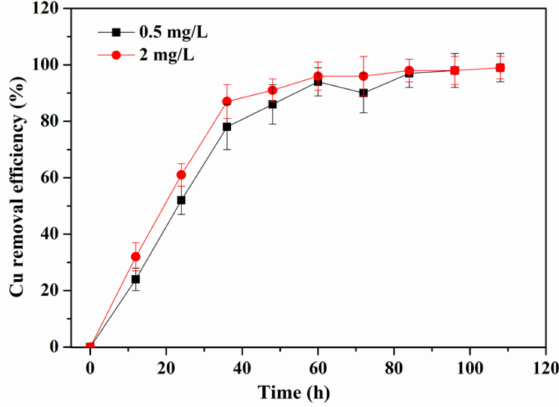
Figure 2. Cu 2 + removal e ffi ciency by the periphyton at Cu 2 + concentrations of 0.5 and 2 mg /